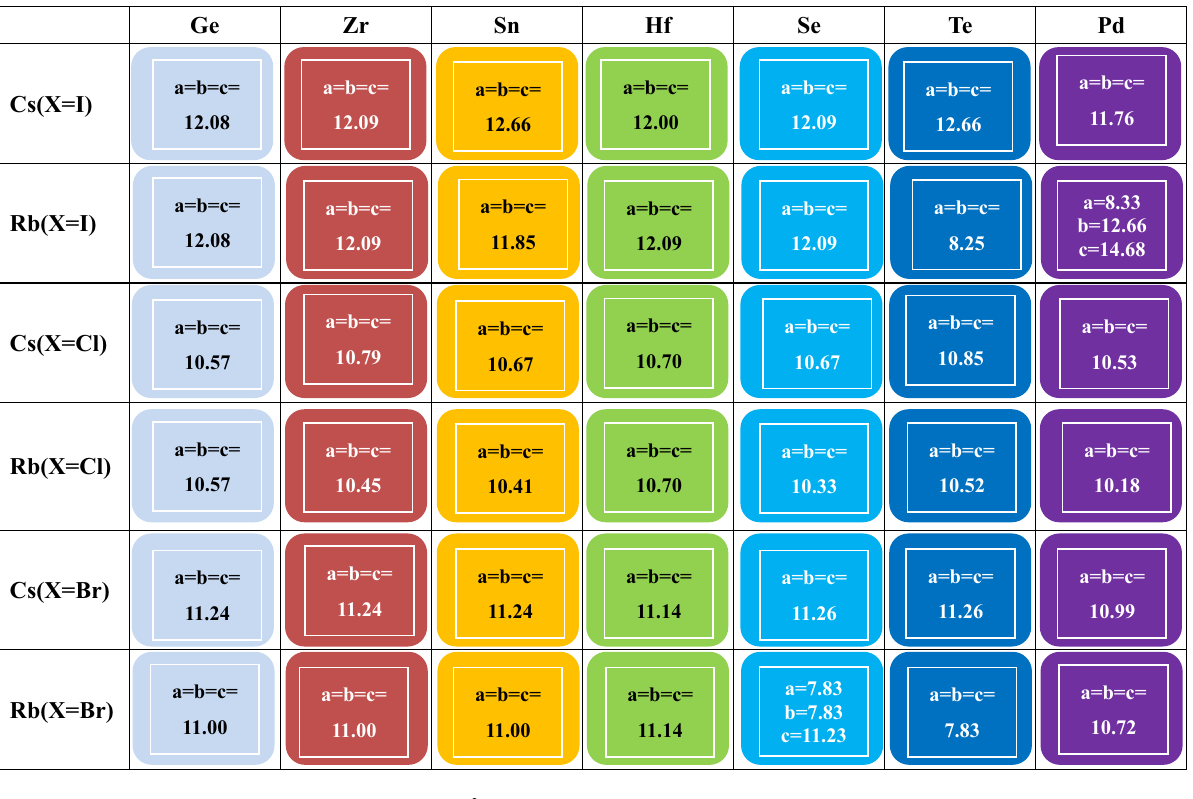
Figure 4. Lattice parameters of A 2 BX 6 .